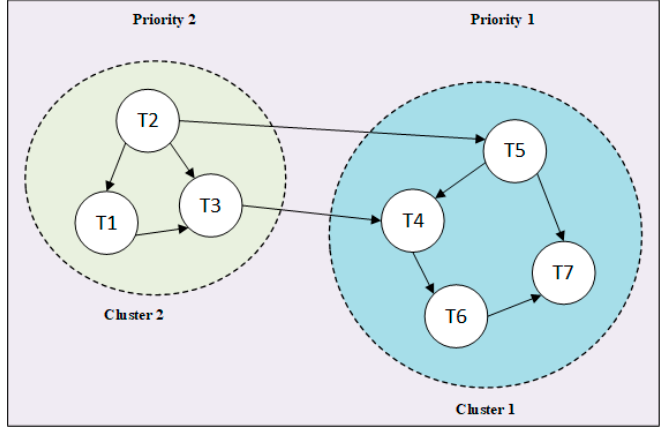
Figure 3. Task clustering.